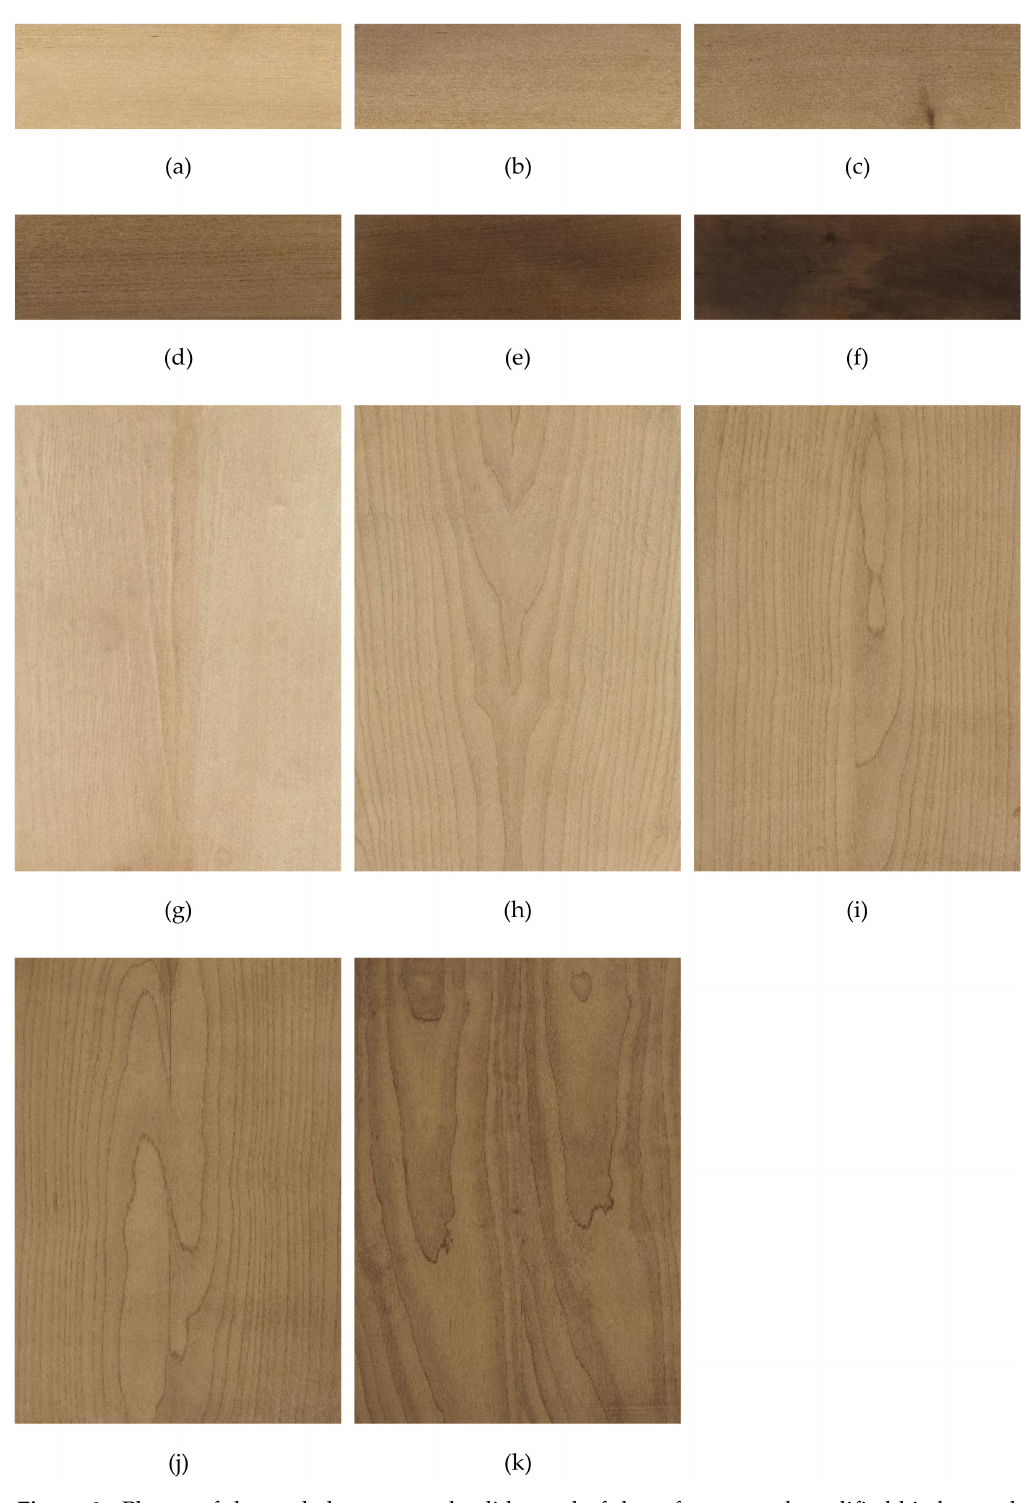
Figure 3. Photos of the peeled veneer and solid wood of the reference and modified birch wood intended for the marketing evaluation. Solid wood—untreated ( a ), solid wood—treated at 160 ◦ C / 3 h ( b ), solid wood—treated at 170 ◦ C / 3 h ( c ), solid wood—treated at 180 ◦ C / 3 h ( d ), solid wood—treated at 190 ◦ C / 3 h ( e ), solid wood - treated at 200 ◦ C / 3 h ( f ), veneer—untreated ( g ), veneer—treated at 170 ◦ C / 3 h ( h ), veneer—treated at 190 ◦ C / 3 h ( i ), veneer—treated at 190 ◦ C / 5 h ( j ), veneer—treated at 200 ◦ C / 3 h ( k